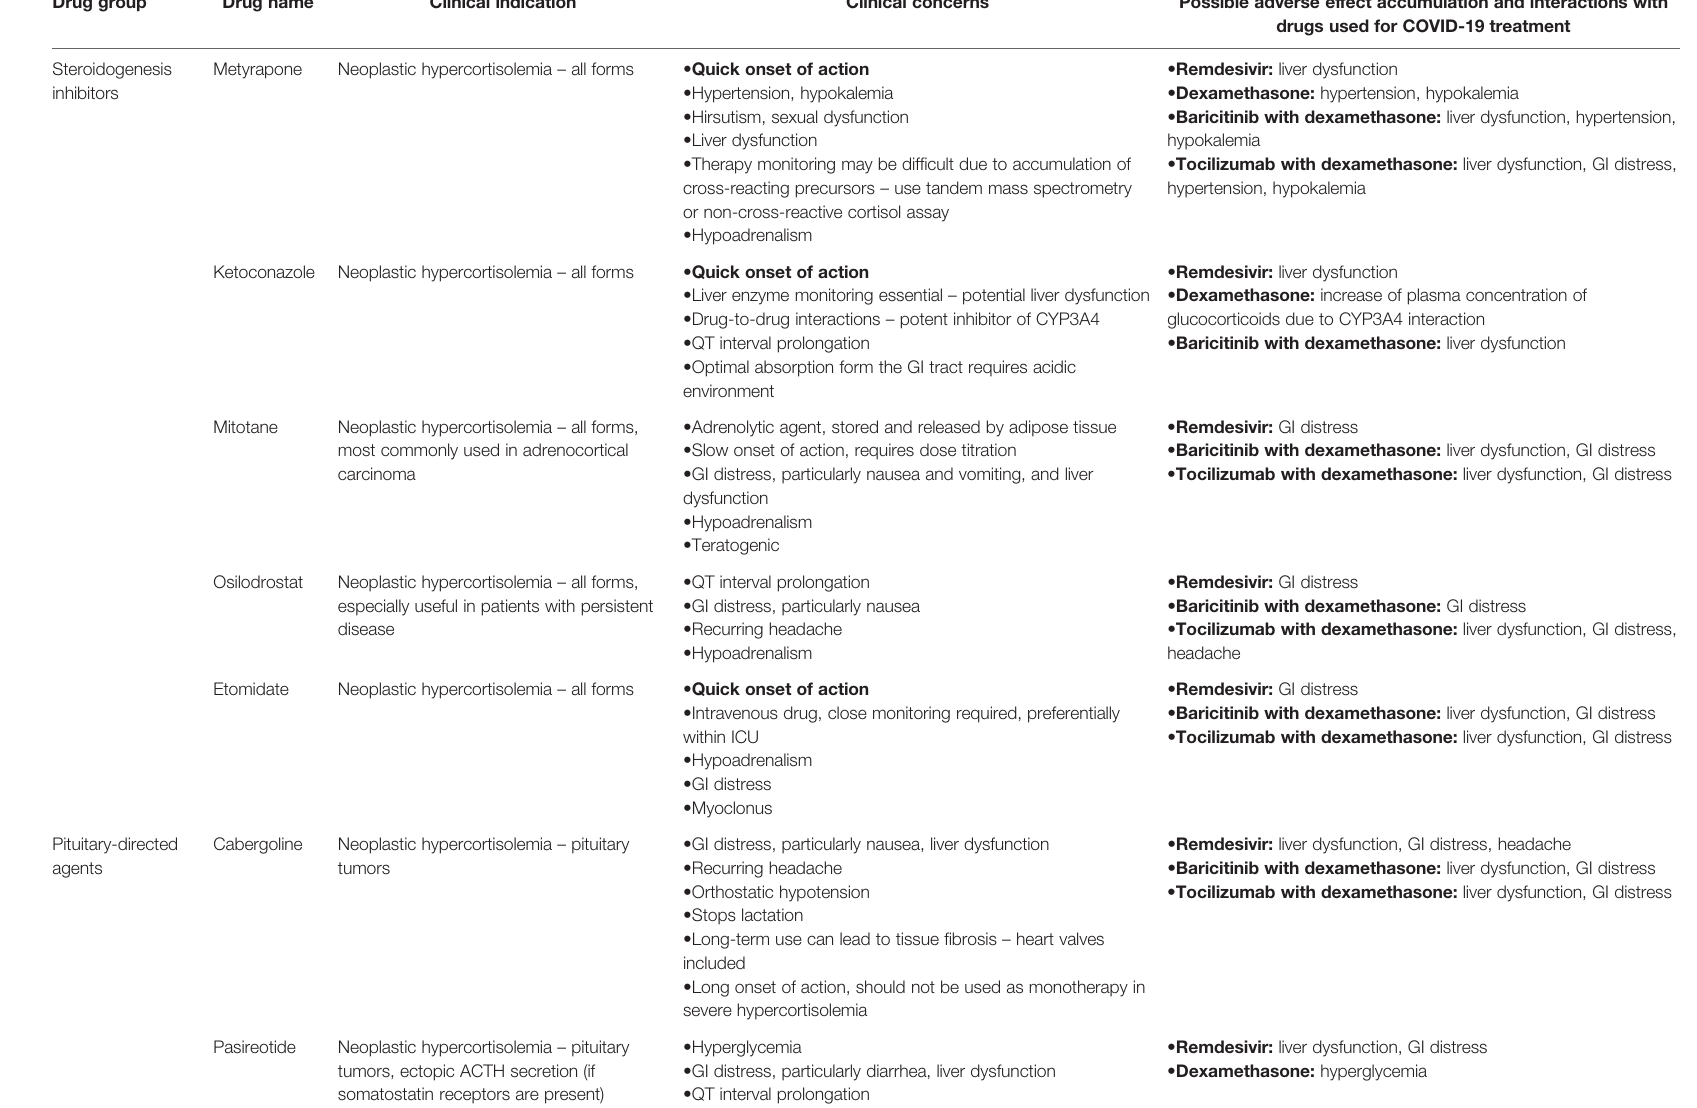
TABLE 1 | An overview of medical treatment commonly used in neoplastic hypercortisolemia. Drug